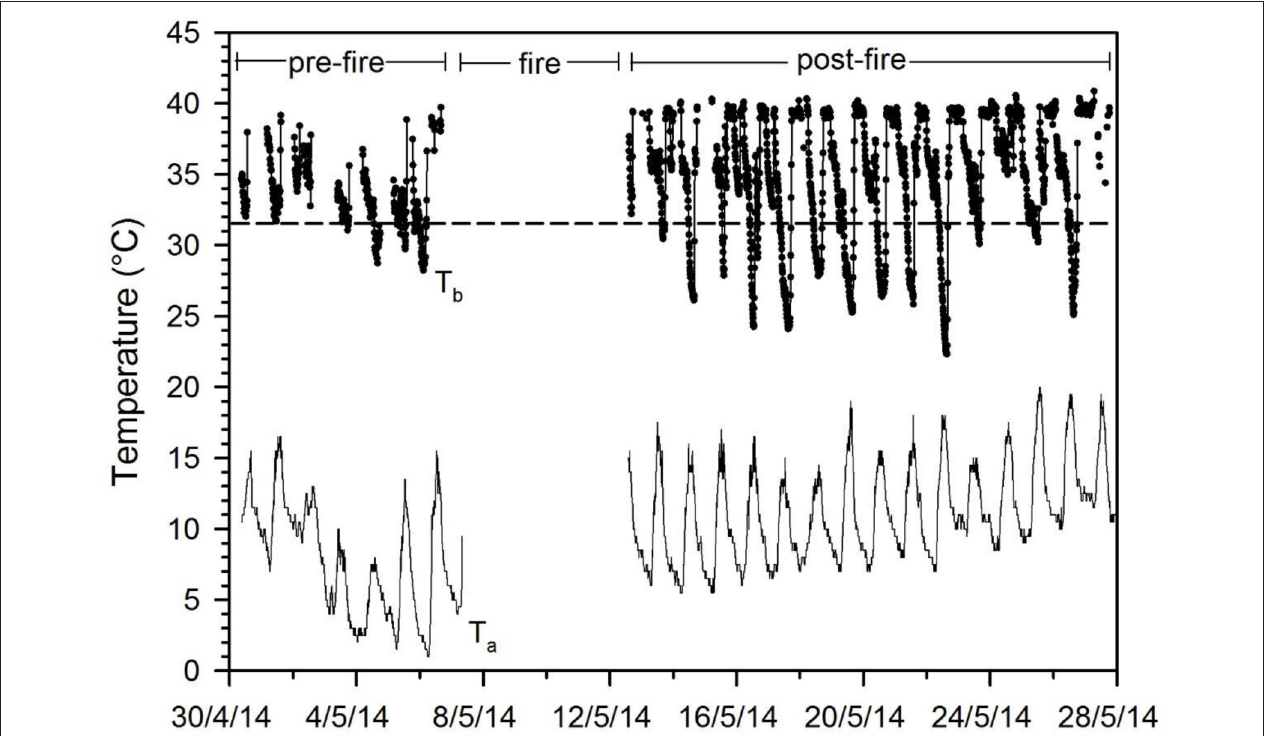
FIGURE 1 | Body temperature (T b ) and ambient temperature (T a ) fluctuations in the free-ranging marsupial Antechinus stuartii in the late Austral fall before and after a controlled forest fire. Access during the fire for data collection was not permitted. Note the substantial increase of the T b fluctuations and prolonged duration of torpor bouts after the fire although T a increased somewhat during that time in comparison to before the fire (data from Stawski et al., 2015). The horizontal dashed line is the torpor threshold.